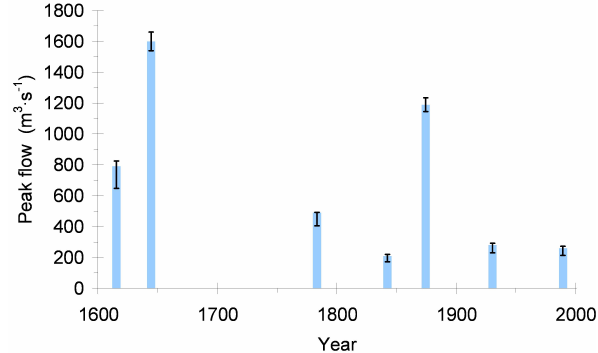
Fig. 10. Modelled peak flows of the major floods occurred in the Ondara River in T`arrega since the 17th century and their uncertain-